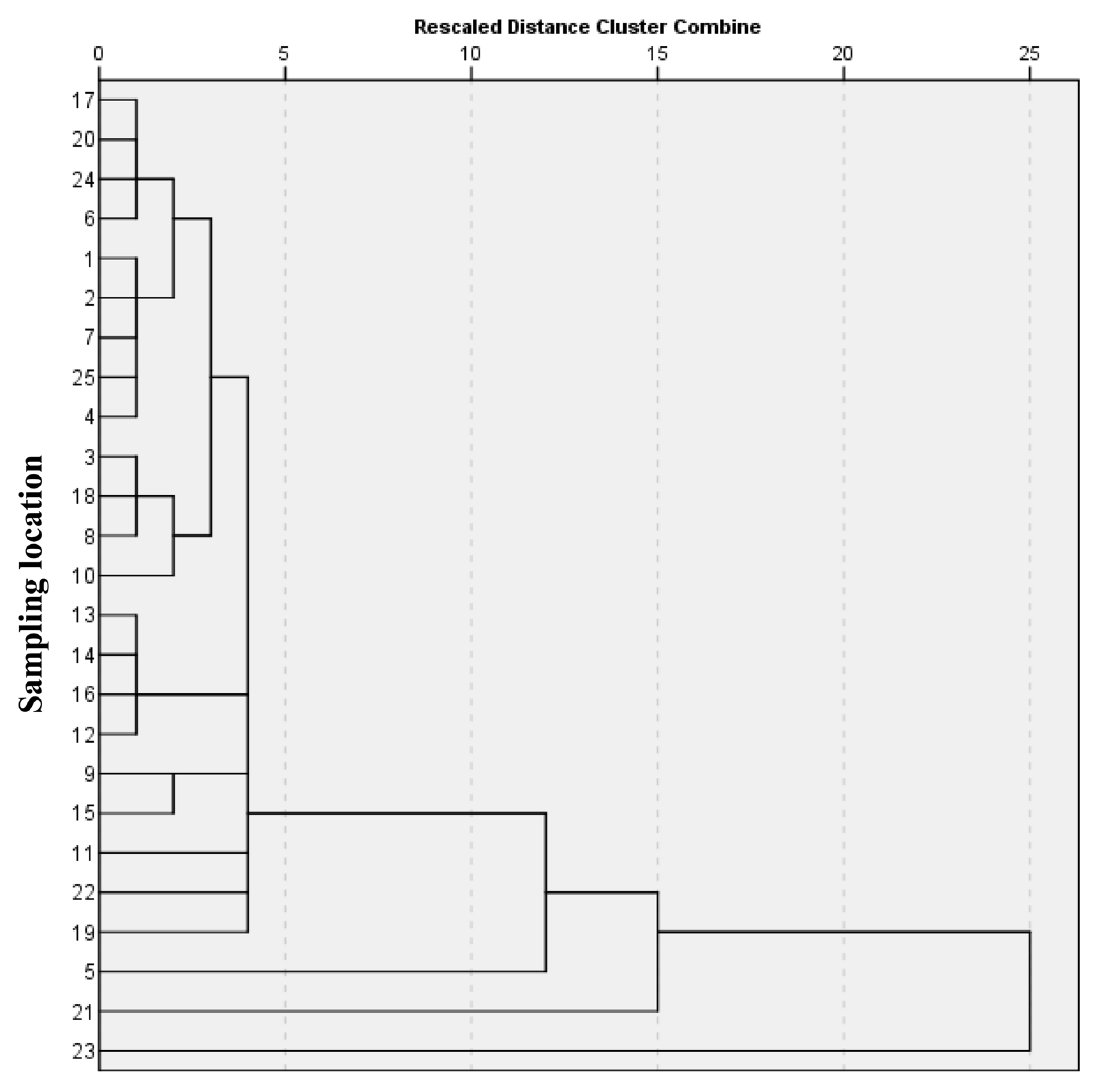
Fig. 4 Cluster analysis of the locations with respect to analysed